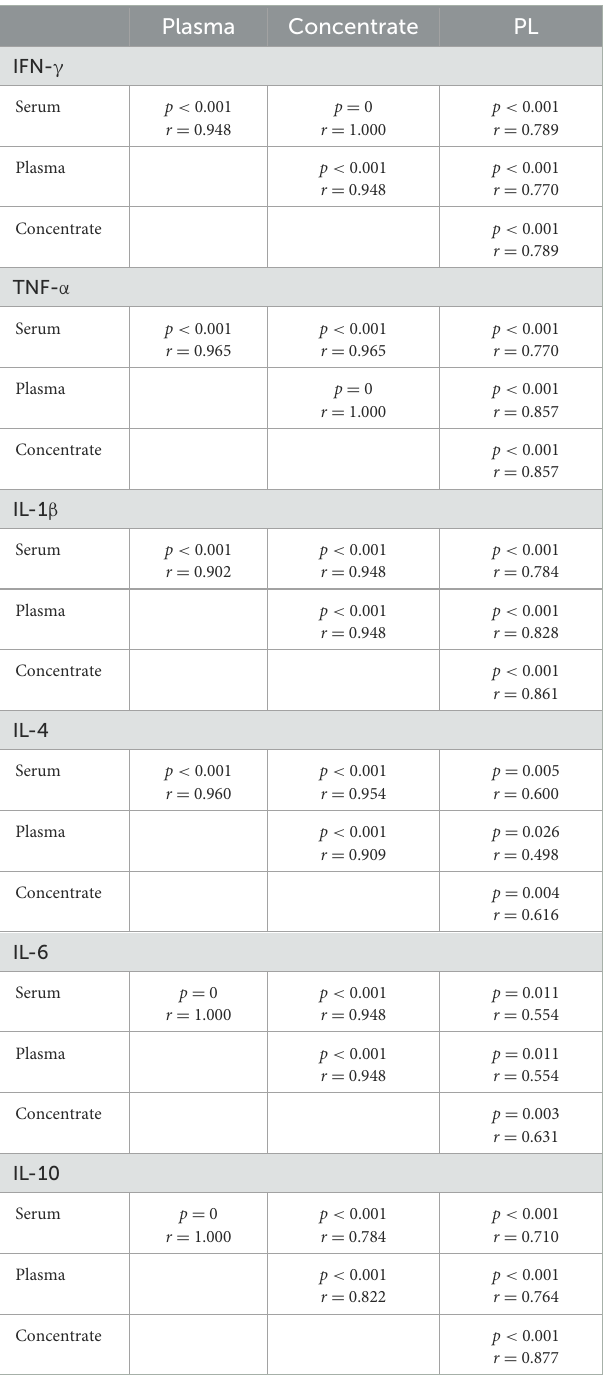
TABLE 2 Correlations of cytokine concentration categories between the different blood